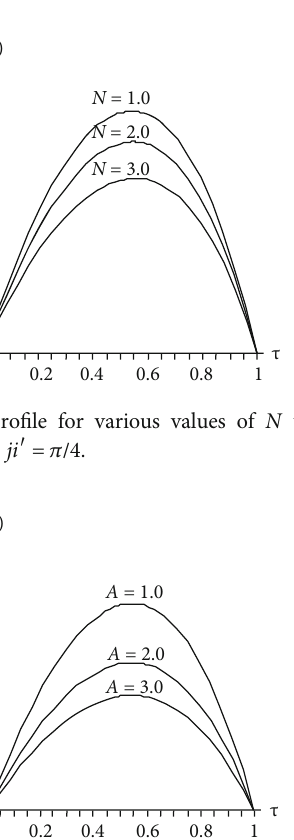
Figure 5: Velocity pro fi le for various values of q with N = 1 : 0 , R = 1 : 0 , A = 1 : 0 , and ji ′ = π /4